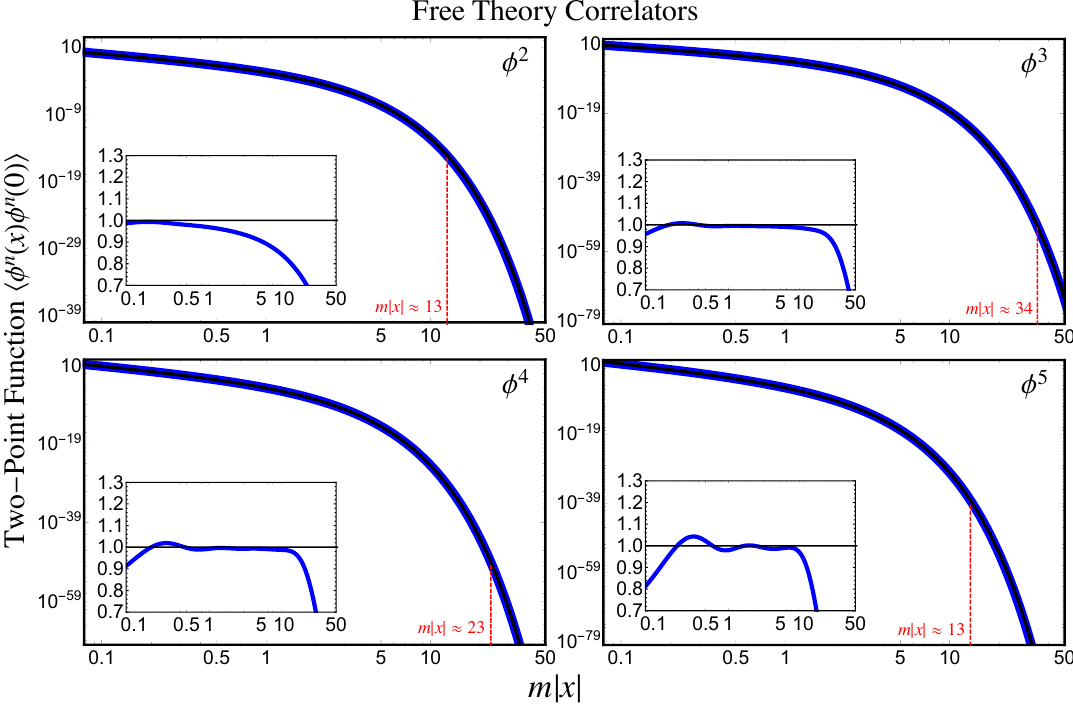
Figure 4 . The free massive theory ( ¯ g = 0 ) two-point functions h φ n ( x ) φ n (0) i for φ 2 (top left), φ 3 (top right), φ 4 (bottom left), and φ 5 (bottom right). The LCT data (blue) was obtained with the same parameters as figure 3, and is compared to the theoretical prediction (black line). The insets show the ratio of the data to the analytical result. To guide the reader, red dashed lines and text show the scale at which the correlator deviates from the theory prediction by 20